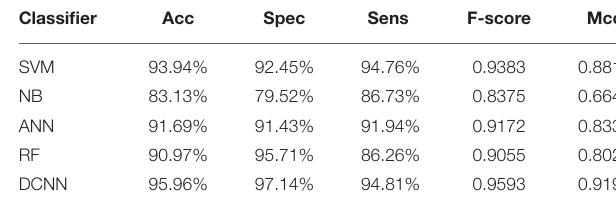
Frontiers in Cell and Developmental Biology |